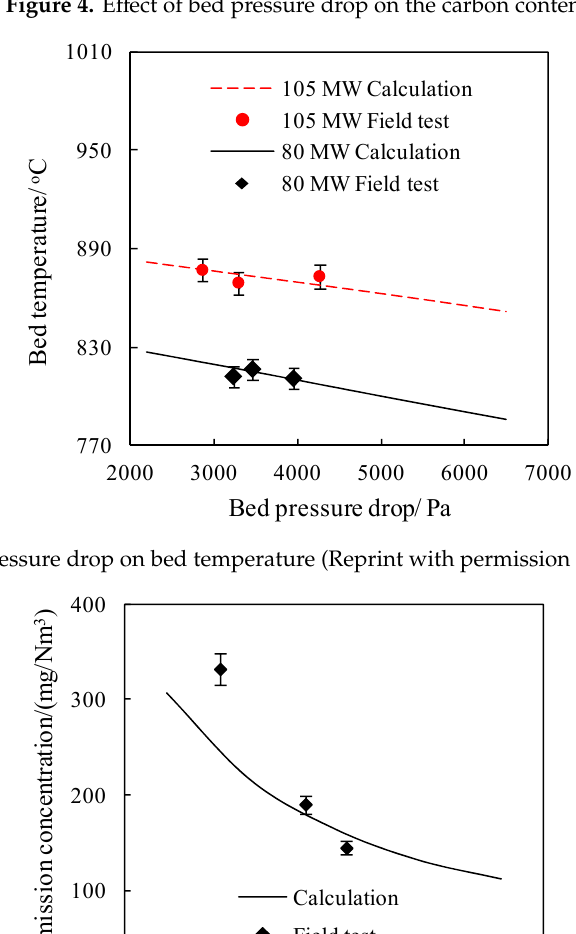
Figure 5. Effect of bed pressure drop on bed temperature (Reprint with permission [6]; 2015, Powder Technol.).